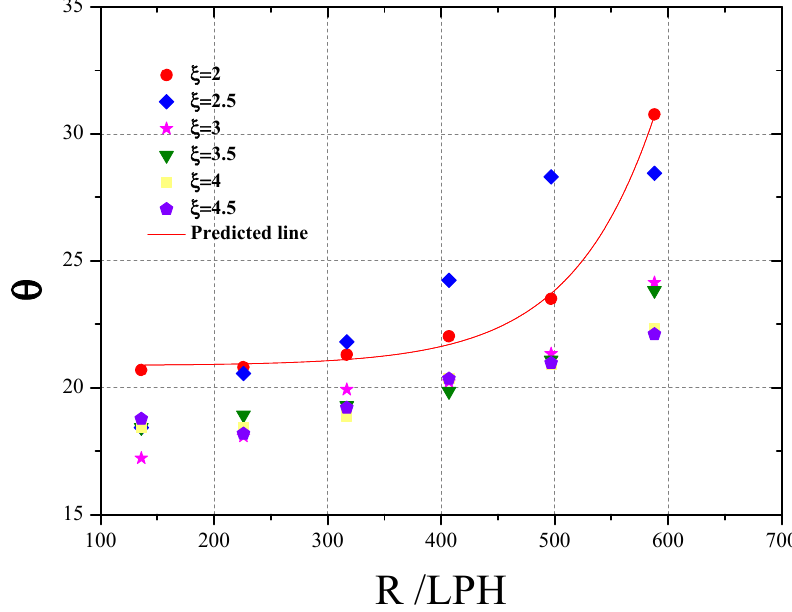
Figure 9. Oscillation angle of bubbly flow at the various gas volume fluxes.